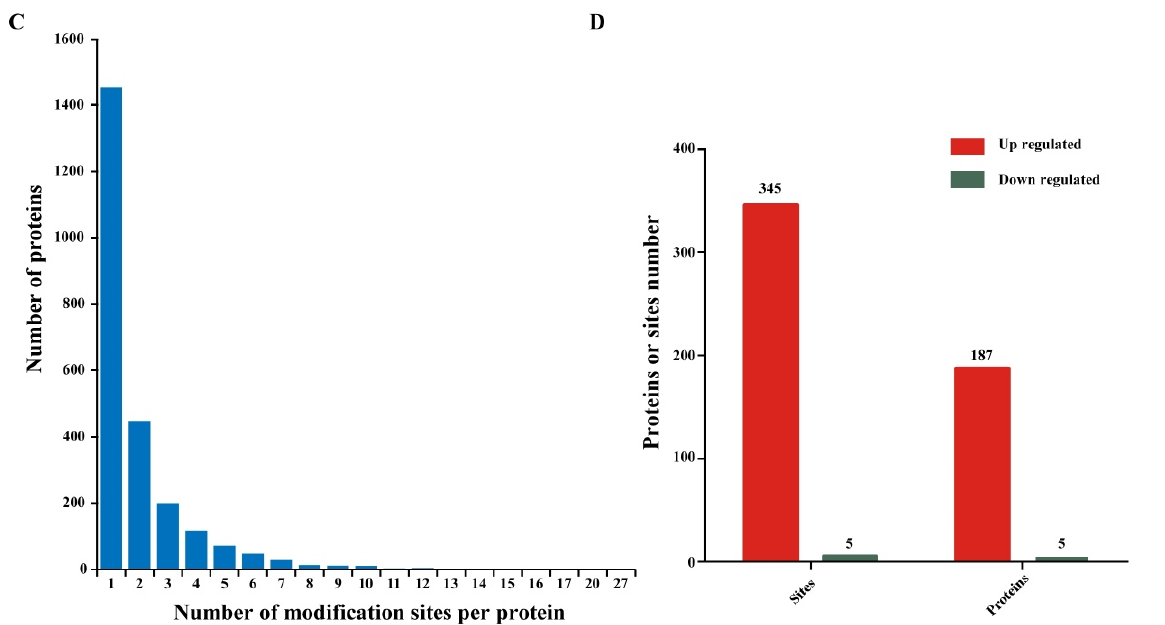
Figure 2. Characteristics of lysine-ubiquitinated sites and proteins in wheat. ( A ) Mass error distribution of all the identified peptides. ( B ) Peptide number and length distribution of all the ubiquitinated peptides. ( C ) Distribution of ubiquitination sites in the ubiquitinated proteins. ( D ) Differential expression of ubiquitinated proteins and site identification in CWMV-infected wheat.